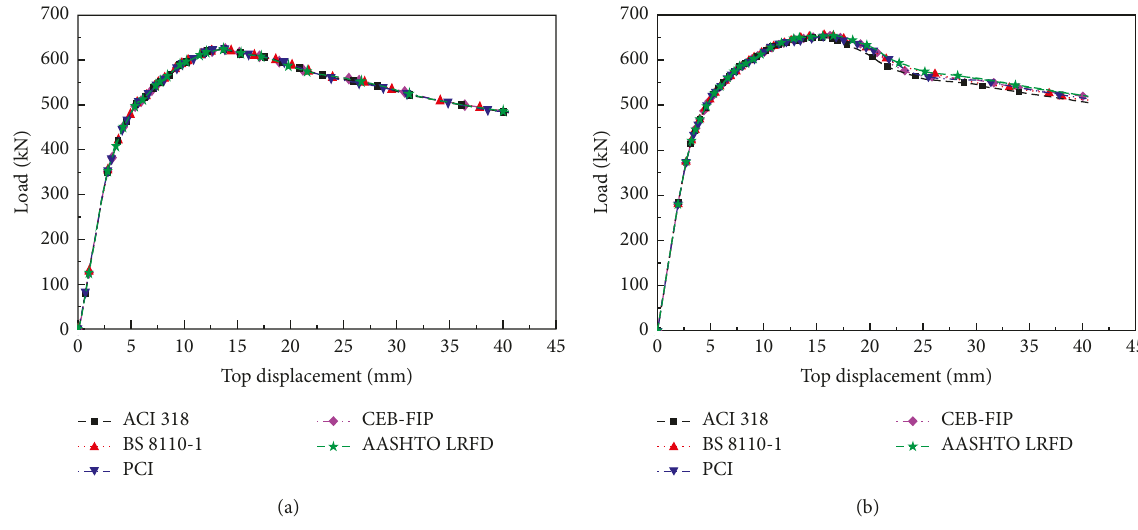
Figure 19: Comparison of load-displacement curves under 0.3 axial compression ratio: (a) W2 and (b) W3.